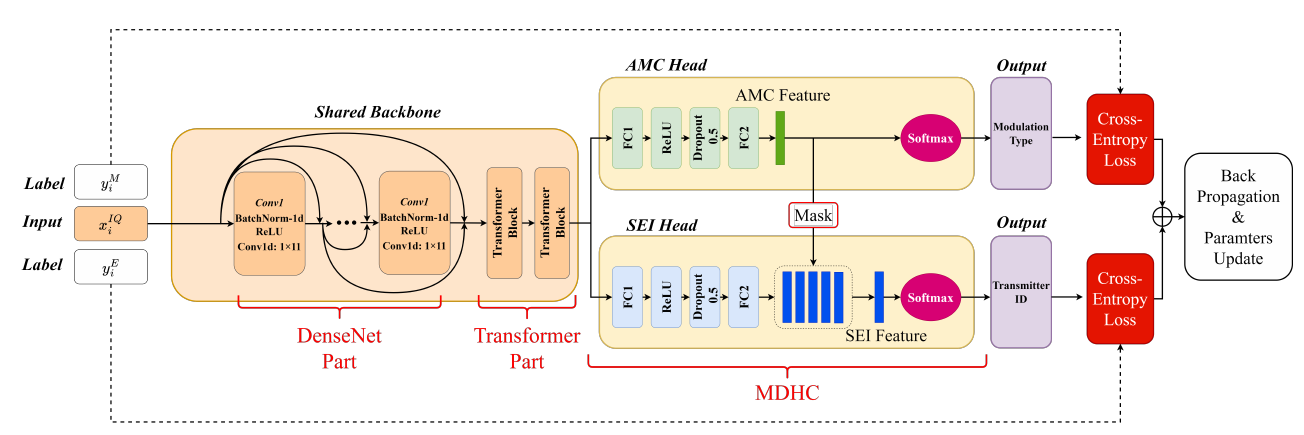
Figure 4. Schematic diagram of forward and backward propagation of AMSCN.